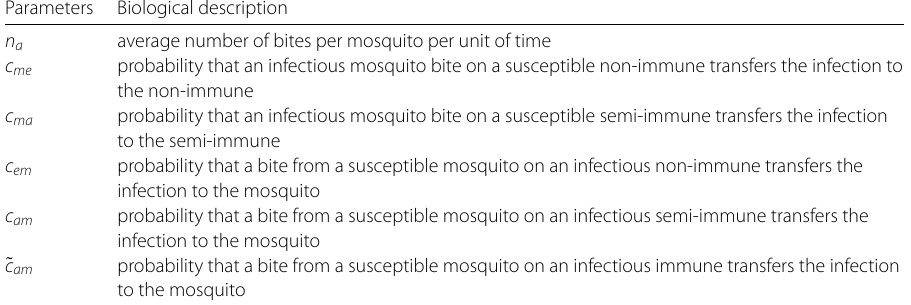
Table 6 Parameters for the non-immune hosts Parameters Biological description ν e rate of passage from latent non-immune to infectious α mortality rate due to malaria on